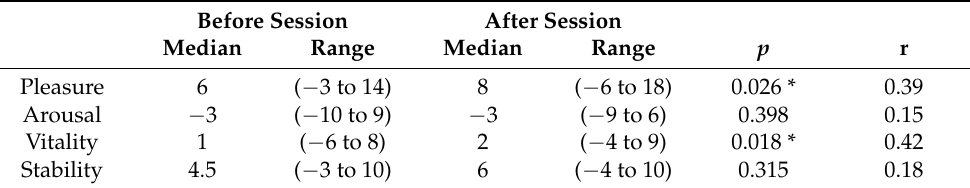
Table 2. Results of mood scores before and after the first session (n = 32).